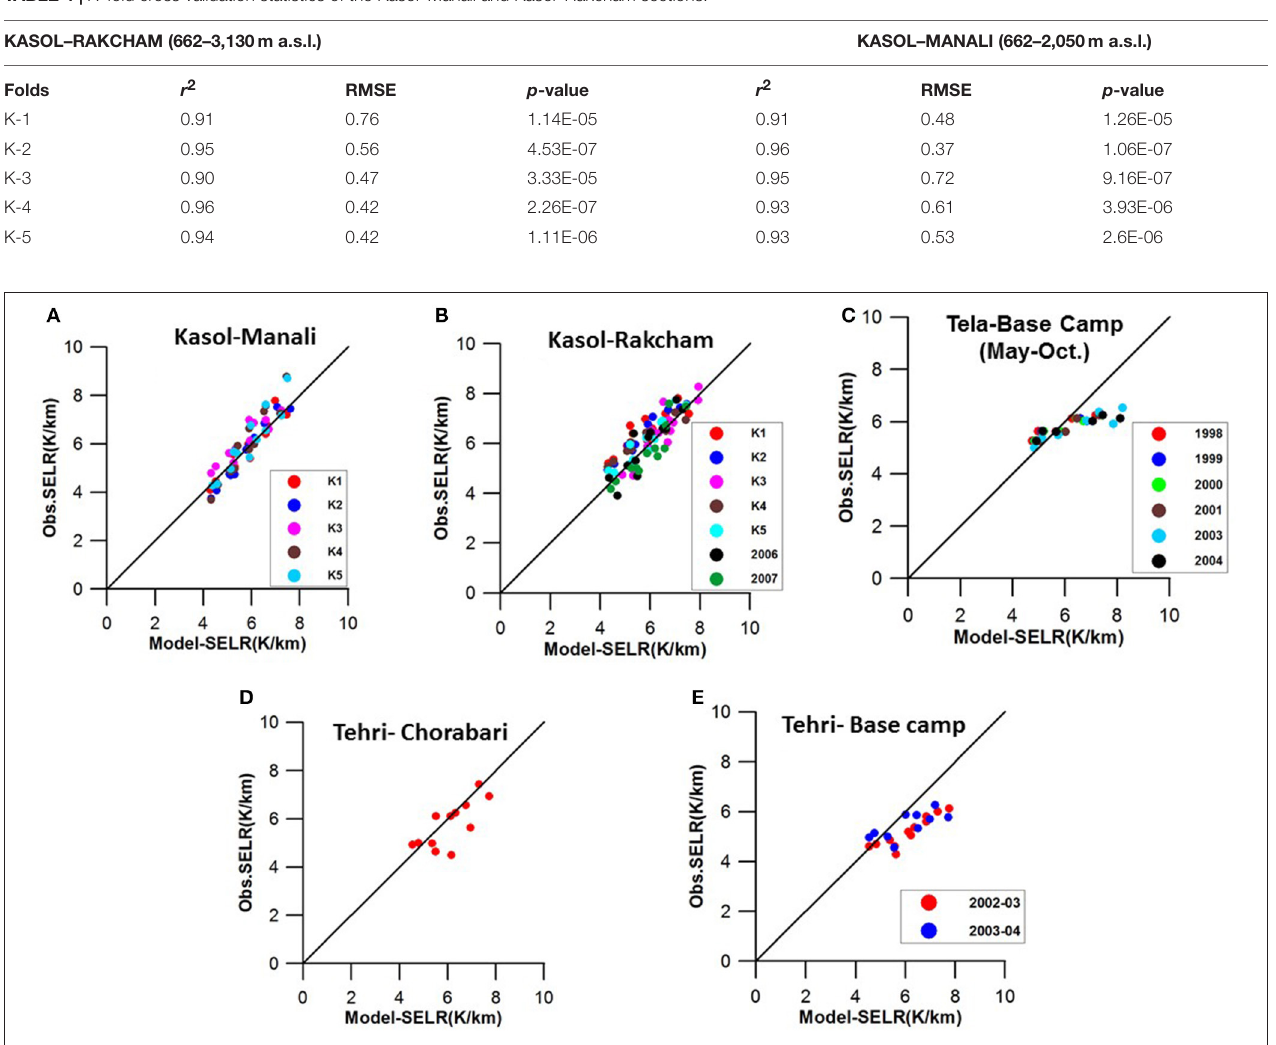
FIGURE 7 | Relationship between modeled and observed SELR using regional indices derived by K -fold cross validation. Regional indices were tested against each test folds of Kasol–Manali (A) and Kasol–Rakcham (B) sections as well as for the new data set of 2006 and 2007. Regional indices were further tested for different profiles of the upper Ganga basin (C–E) showing the significant improvement achieved through cross validation and its regional validity.